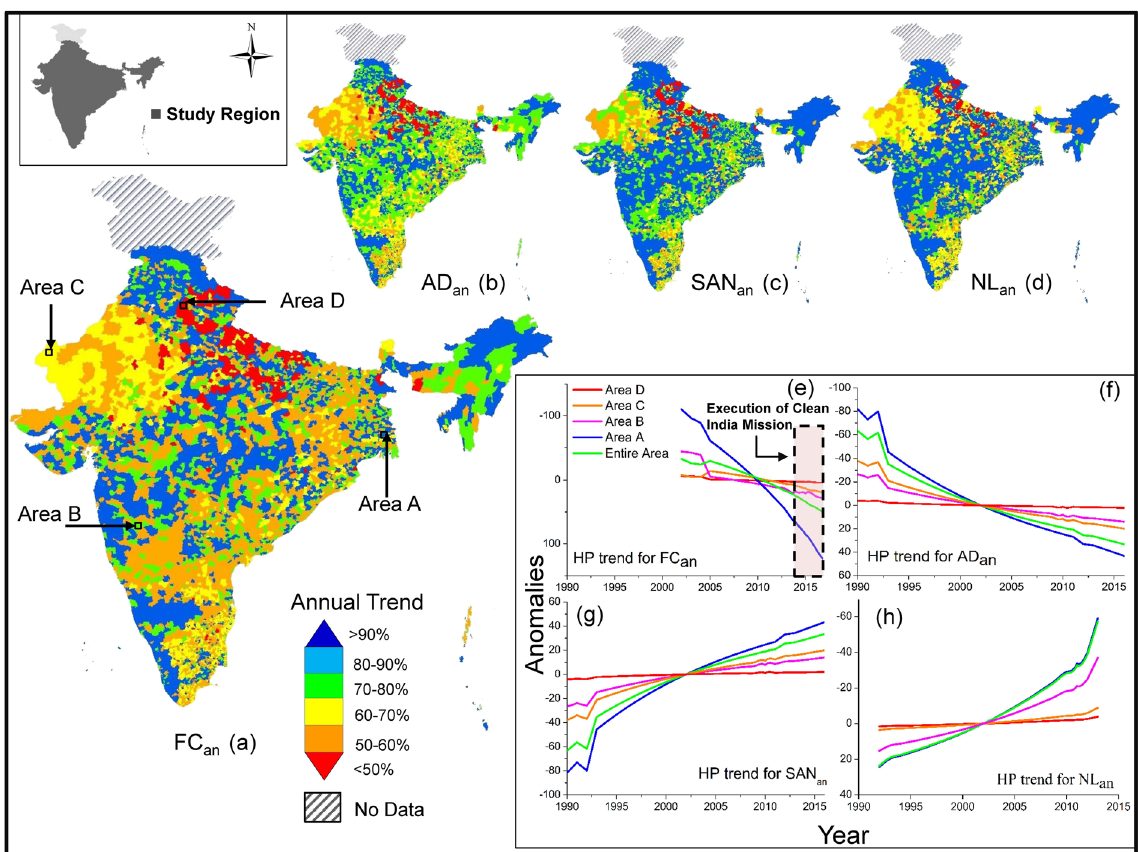
Figure 1. Map of study area across India, showing ( a ) annual linear trend of groundwater fecal coliform anomaly (FC an , 2002–2017) in each of the administrative blocks or equivalents (BLKs, n = 7010 BLKs) within the study period across the study region (shown in the inset map on top left). Linear slope of FC an for the entire study area is − 2.56 ± 0.06%/year for the data period. The map also show locations of the detailed study areas A (located in Highly Improved, FC an decrease > 90% within the study period), B (Improved, > 70–90%), C (Moderately Improved, > 50–70%) and D (Less Improved, < 50%); annual linear trends of anomalies of ( b ) acute diarrheal cases (AD an , 1990–2016, − 2.93 ± 0.03%/year for entire study area), ( c ) household sanitation structures (SAN an , 1990–2017, 2.63 ± 0.06%/year) and ( d ) night-time light (NL an , 1992–2013, 4.26 ± 0.05%/ year); ( e – h ) non-linear, Hordick Prescott (HP) trends of the entire and detailed study areas (A, B, C and D) for FC an , AD an , SAN an and NL an